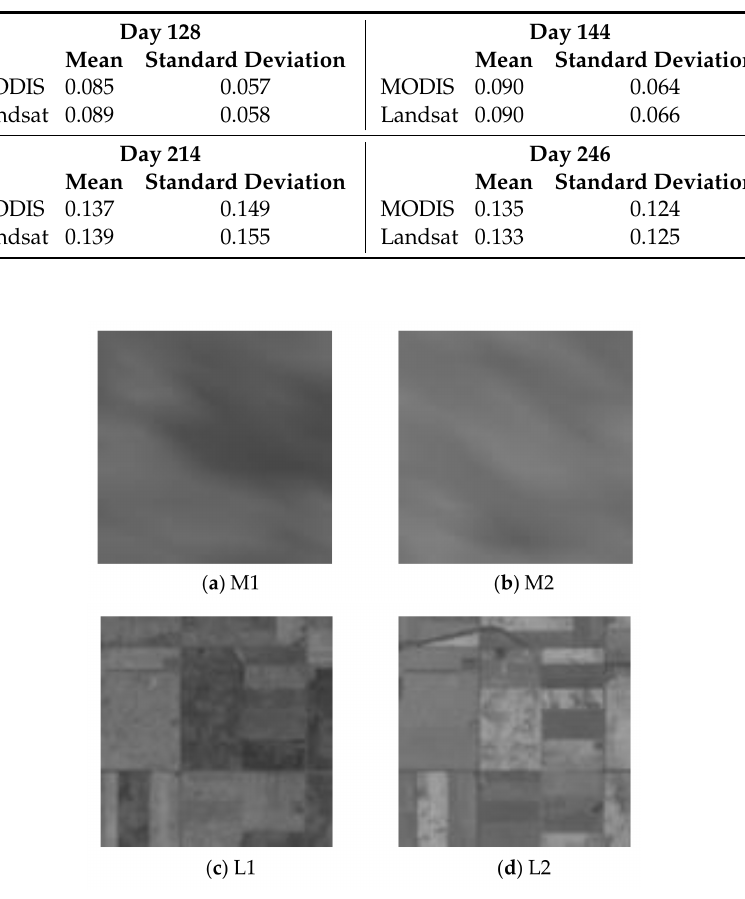
Figure 1. Relationship between two pairs of MODIS and Landsat images. One band is shown here. ( a , b ) are MODIS images collected at two different times; ( c , d ) are Landsat images collected at two different